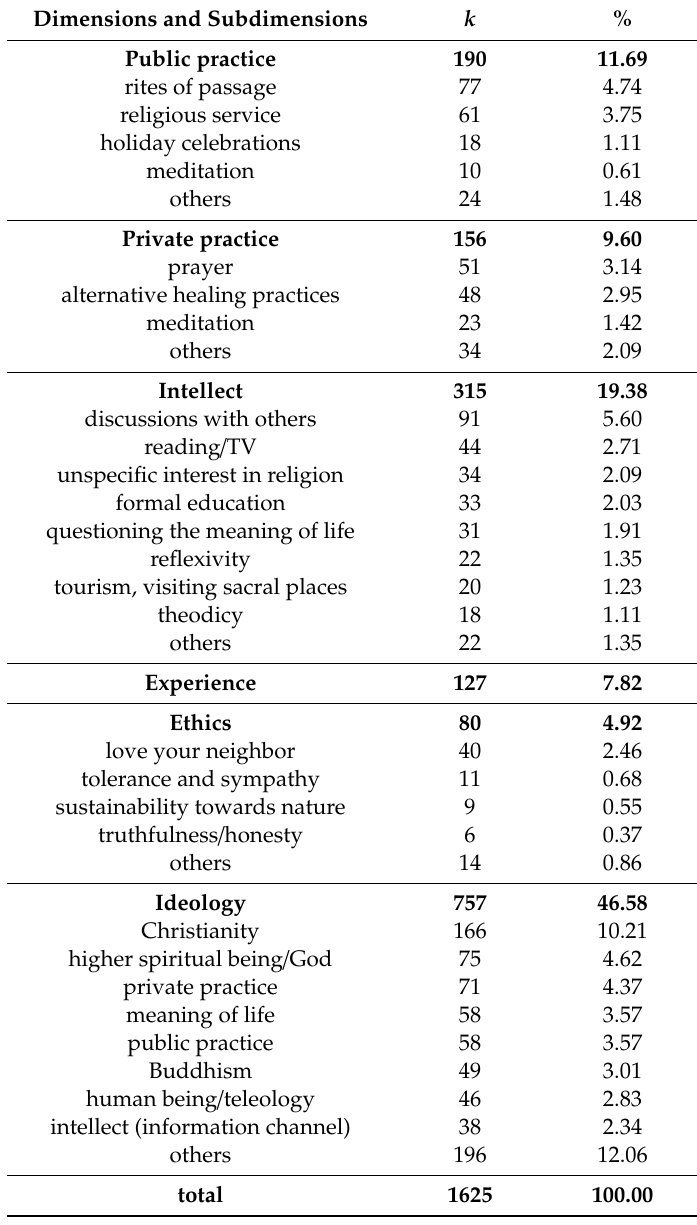
Table 1. Of the frequency analysis of dimensions and subdimensions of spirituality according to Huber’s model (K =